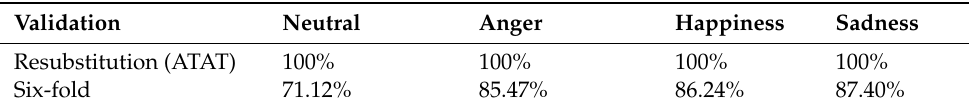
Table 4. Performance of affective computing for emotion activation.